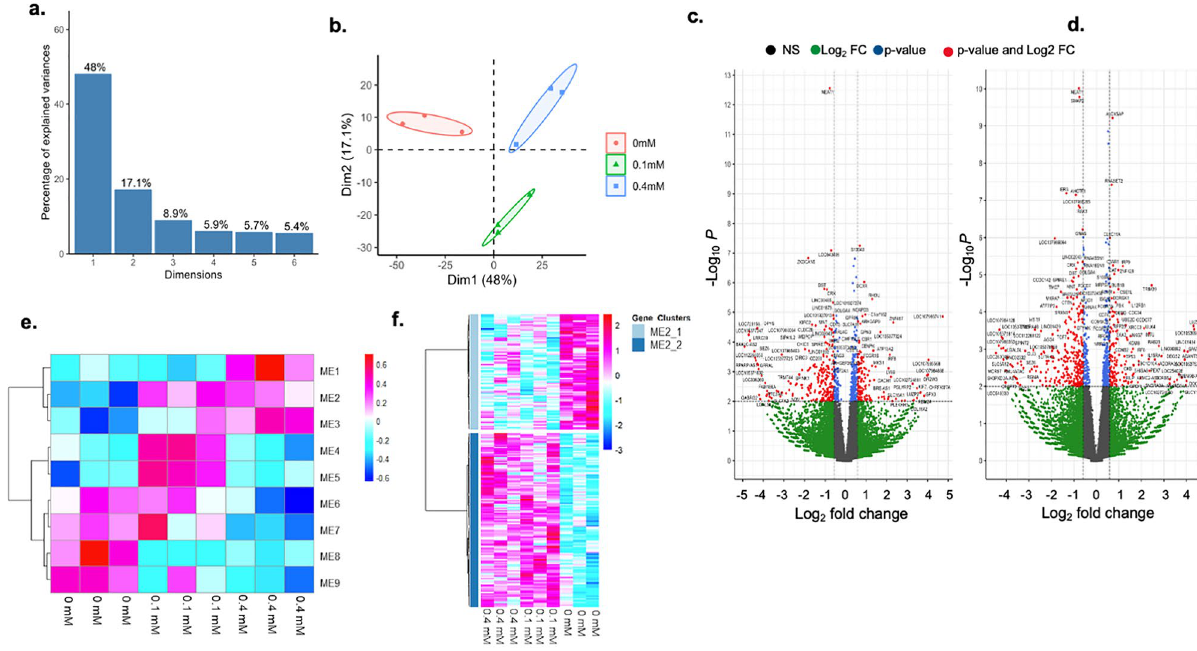
Figure 2. PCA analysis, volcano plot and cluster analysis for identified DEGs of THP-1 macrophages co-cultured with MMNK-1 cholangiocytes when exposed to 1,2-DCP at 0, 0.1 or 0.4 mM for 24 h for 3 independent experiments (n = 3). ( a ) The identified PCA dimensions 1 to 6. ( b ) PCA Dimension 1 and 2 were plotted for each sample. ( c ) screening for DEGs between 0 and 0.1 mM using volcano plot for THP-1 cells where red-colored dots represent genes of p-value < 0.01 and |Log 2 FoldChange| > 0.58, ( d ) screening for DEGs between 0 and 0.4 mM using volcano plot for THP-1 macrophages where red-colored dots represent genes of p-value < 0.01 and |Log 2 FoldChange| > 0.58, ( e ) heatmap representation of co-expressed gene modules identified by the weighted co-expression network analysis of THP-1 macrophages, where each column represents exposure group, whereas each row represents an individual module eigengene, ( f ) heatmap representation of the module eigengene 2 (ME2) of THP-1 macrophages, where each column represents exposure group, whereas each row represents an individual